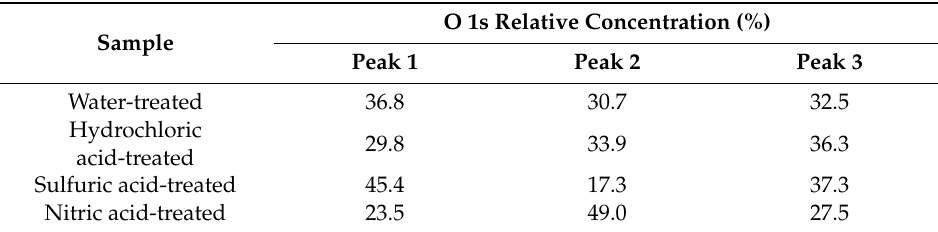
Table 3. Relative content of functional groups in O 1s